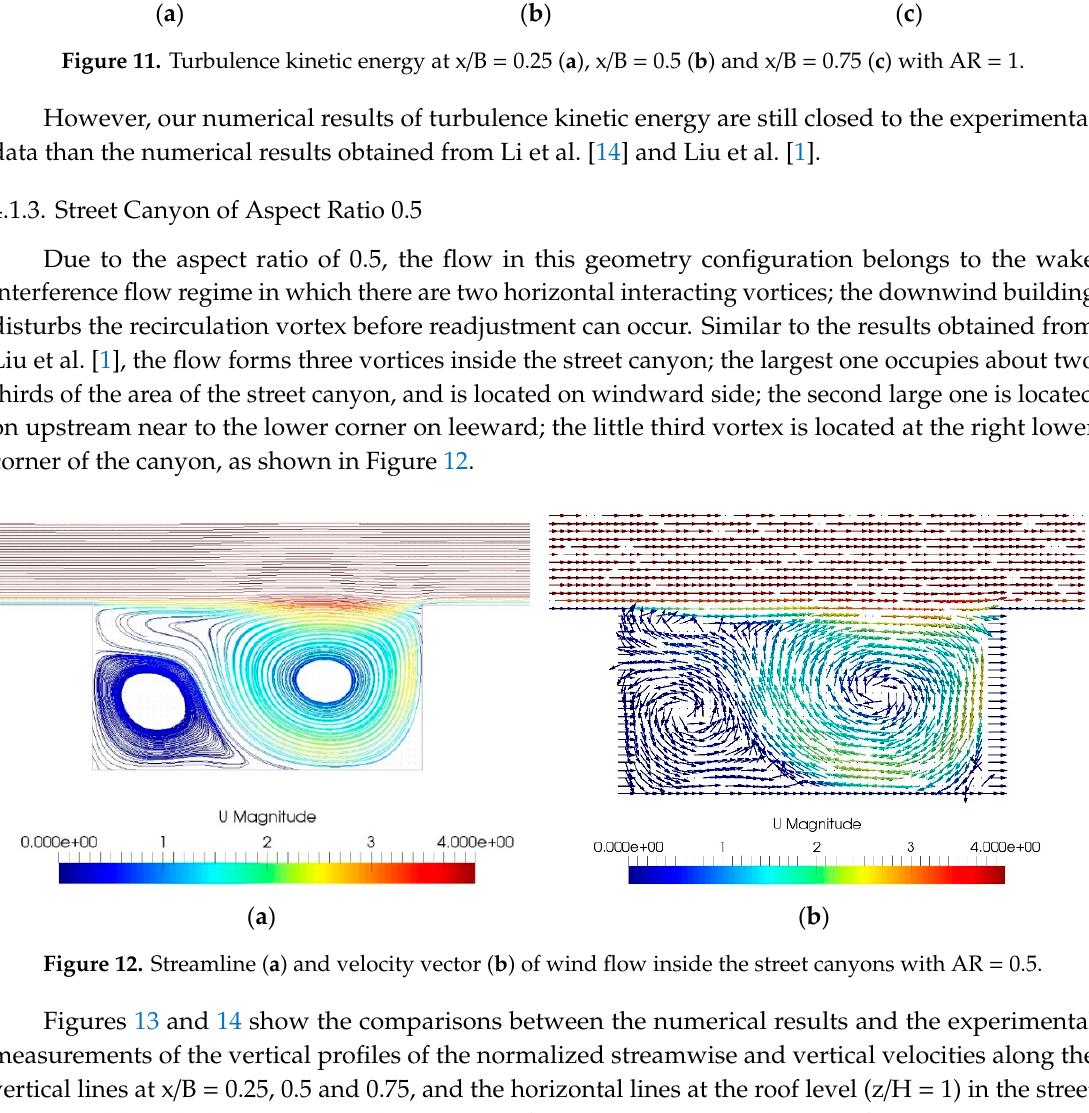
Figure 11. Turbulence kinetic energy at x/B = 0.25 ( a ), x/B = 0.5 ( b ) and x/B = 0.75 ( c ) with AR = 1.